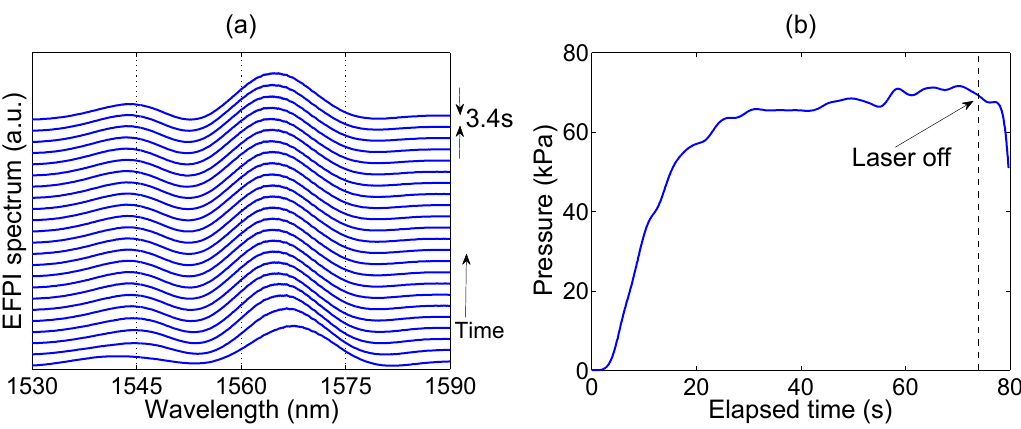
Figure 4. First experiment in pressure detection in LA. ( a ) The chart reports EFPI spectrum evolution (from the bottom to the top), as acquired by the interrogator, sampled each 3.4 s; ( b ) The estimated pressure is then reported as a function of elapsed time, with laser turned on at 0 s and turned off at 74 s.